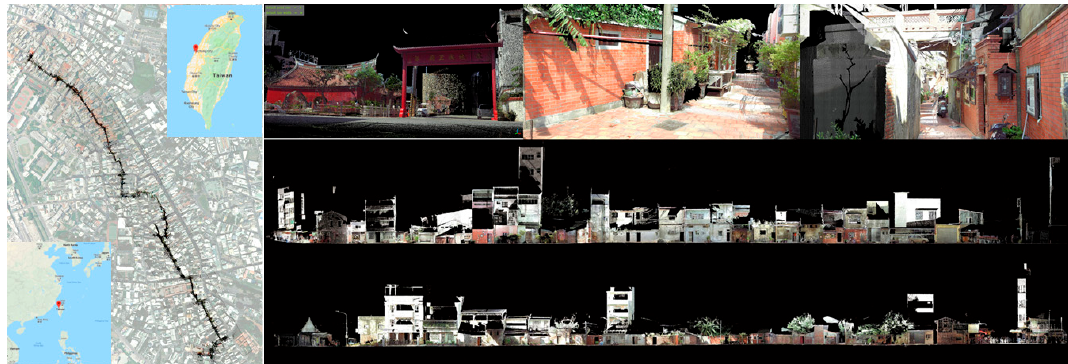
Figure 1. A 2500 m scan of an old street.